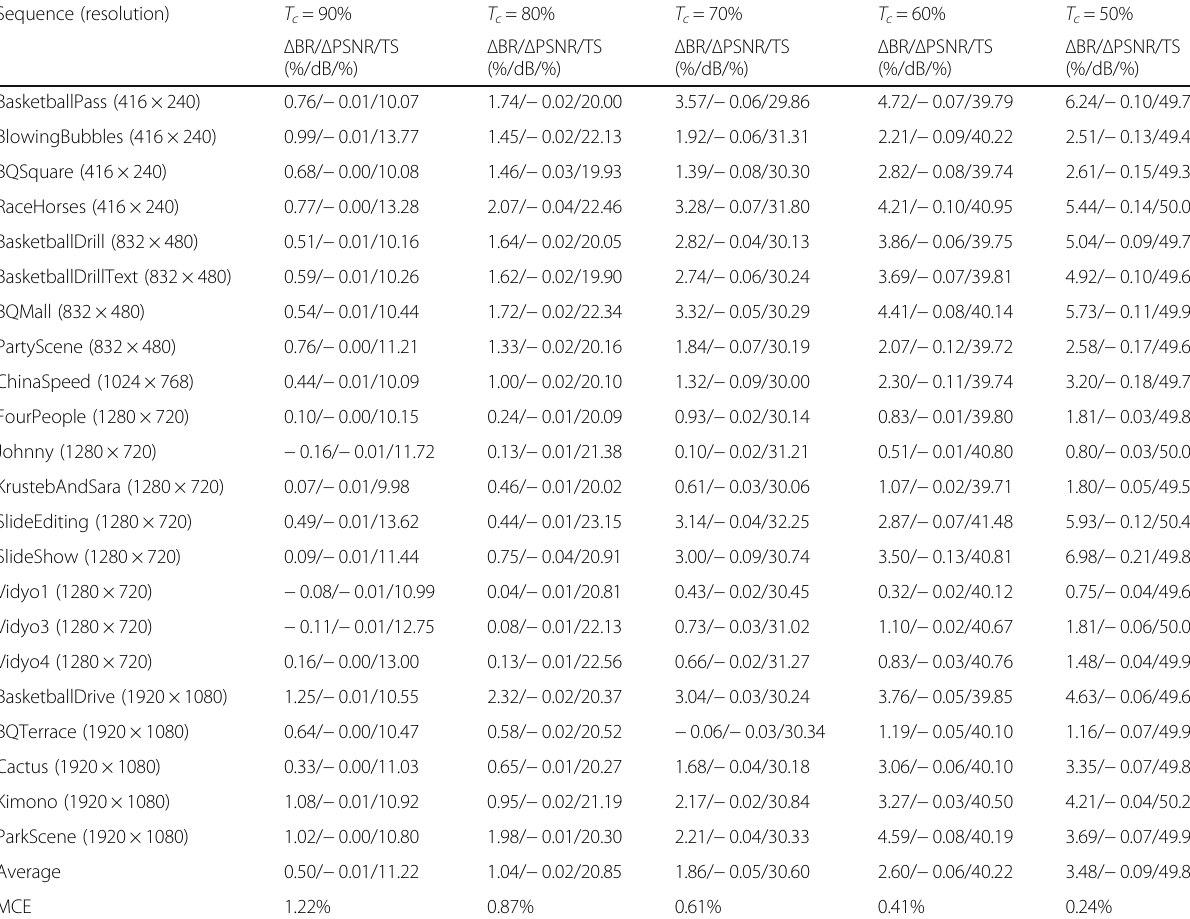
Table 4 Coding performance of the proposed algorithm under different target complexities Sequence